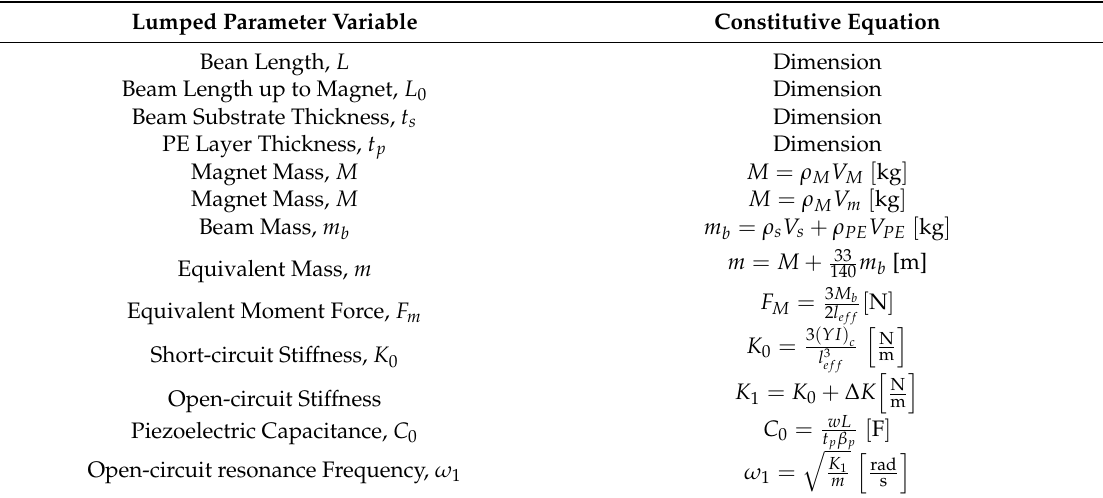
Table 2. Lumped parameters for MME